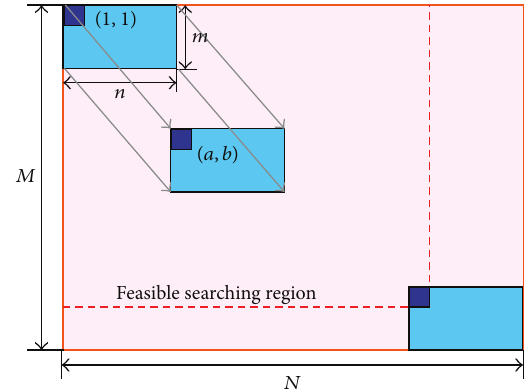
Figure 1: Schematic diagram of template matching